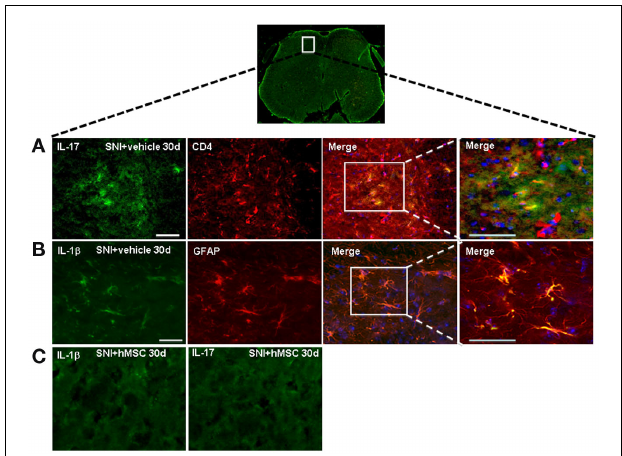
FIGURE 4 | Representative cross-section of mouse L4–L5 spinal cord from 30days-neuropathic mice. (A) First: IL-17 positive profiles (green fluorescent) in vehicle treated 30days-neuropathic mice (SNI + vehicle). Second: CD4 positive profiles (red fluorescent) in vehicle treated 30days-neuropathic mice.Third: double labeling of IL-17 and CD4 positive profiles. Fourth: higher magnification showing that the cells expressing IL-17 wereT lymphocytes. Cell nuclei were counterstained with DAPI (blue fluorescence). Scale bars: 100 μ m. (B) First: IL-1 β positive profiles (green fluorescent) in vehicle treated 30days-neuropathic mice. Second: GFAP positive profiles (red fluorescent) in vehicle treated 30days-neuropathic mice.Third: double labeling of GFAP and IL-1 β positive profiles. Fourth: higher magnification indicating that the cells expressing IL-1 β were astrocytes. Cell nuclei were counterstained with DAPI (blue fluorescence). Scale bars: 100 μ m. (C) First: IL-1 β profiles (green fluorescent) in hMSC-treated 30days-neuropathic mice (SNI + hMSCs). Second: IL-17 profiles (green fluorescent) in hMSC-treated 30days-neuropathic mice (SNI + hMSCs).The absence of positive staining indicates that injected hMSCs were able to reduced the protein levels of